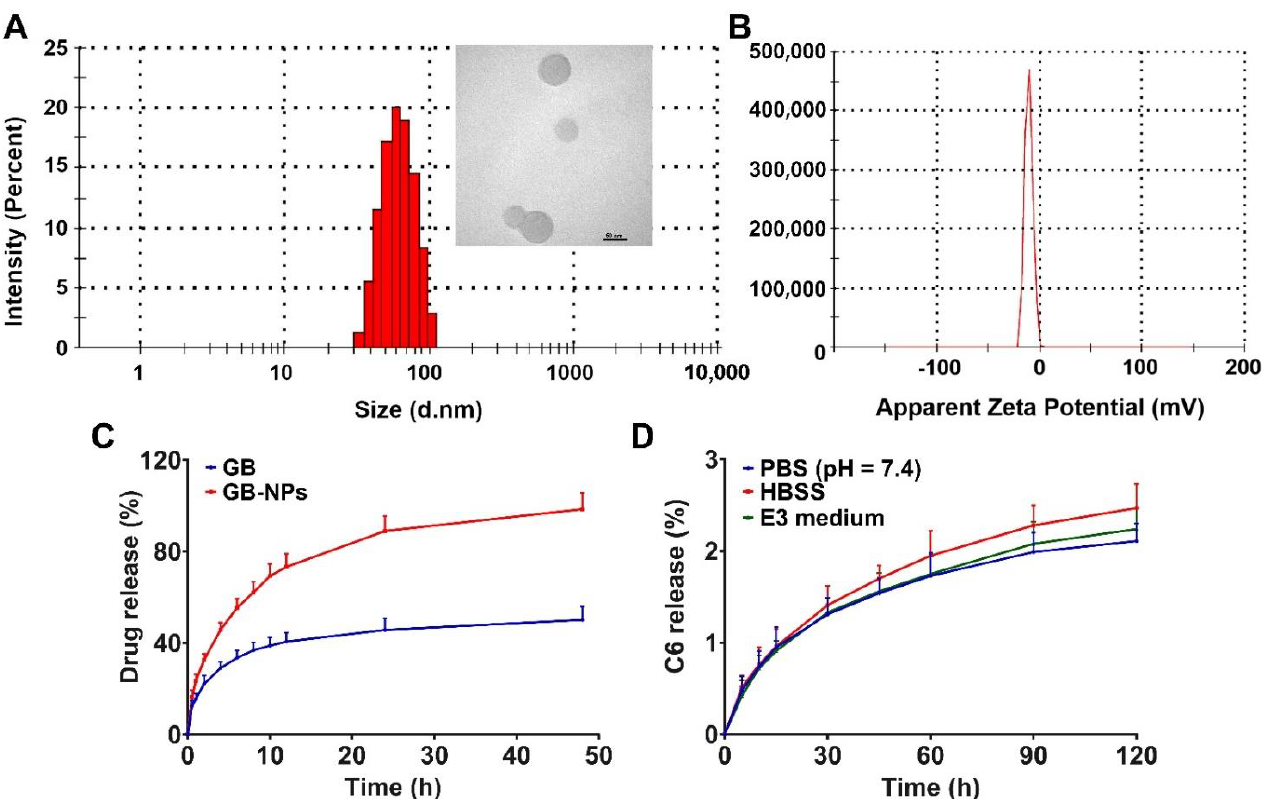
Figure 1. GB-PPNP and C6-PPNP characterization. ( A ) GB-PPNP size and TEM image. Scale bar: 50 nm. ( B ) GB-PPNP surface charge. ( C ) GB drug release from different formulations (means ± SD, n = 3). ( D ) Assessment of C6 leakage from C6-PPNPs in PBS, HBSS, and E3 medium (means ± SD, n = 4).